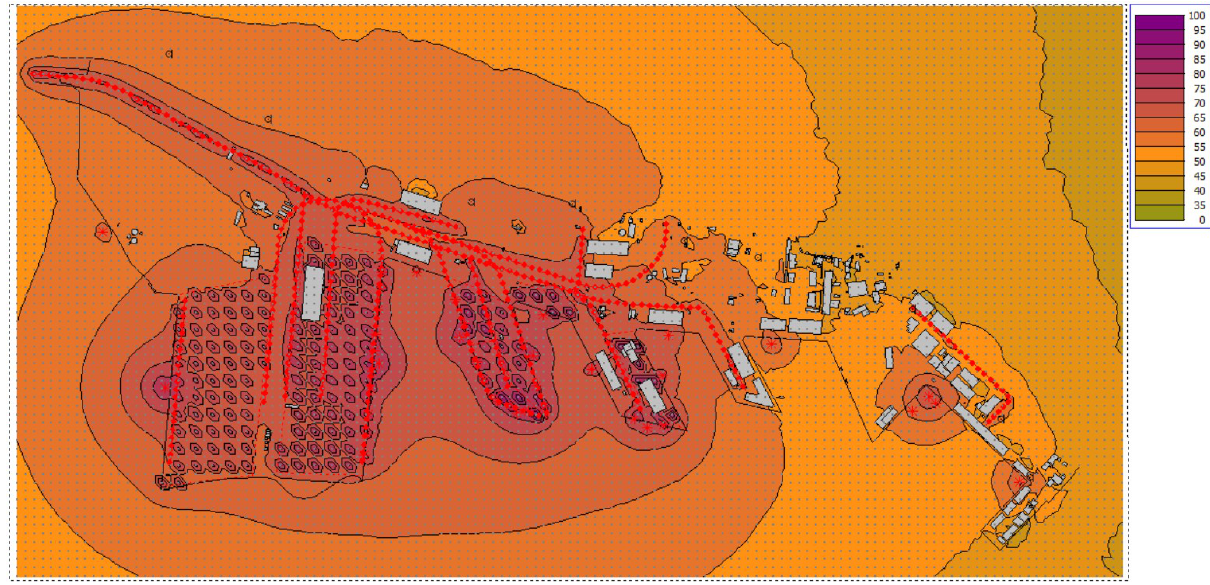
Figure 3: Noise map of the Port of Thessaloniki for the scenario without wind influence (LDEN)